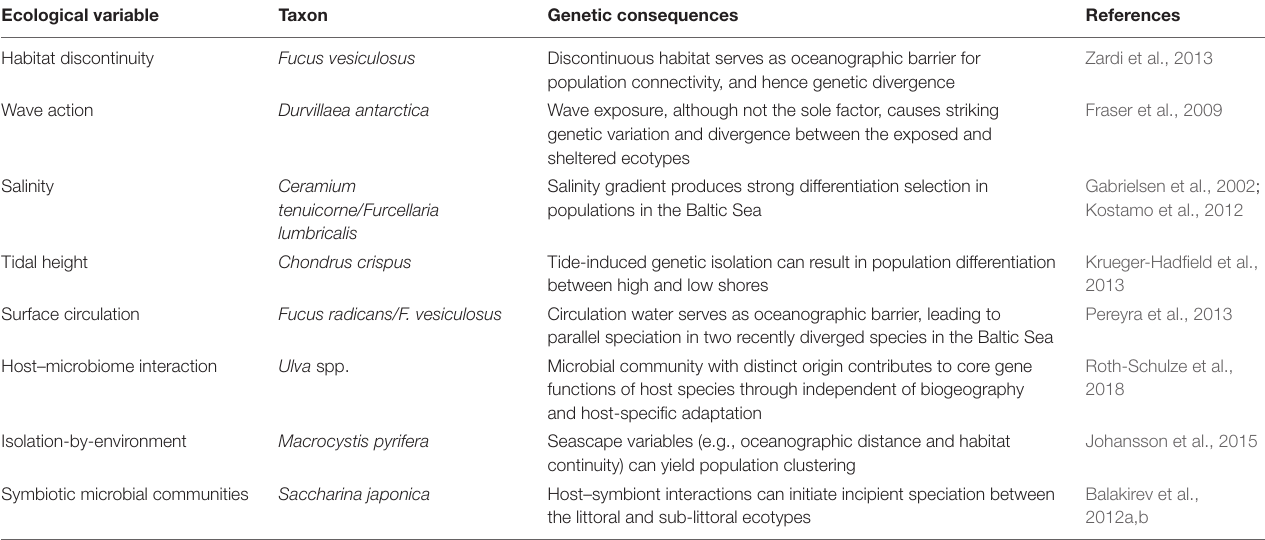
TABLE 2 | Summary of studies illustrating the contribution of ecological variables to genetic differentiation in